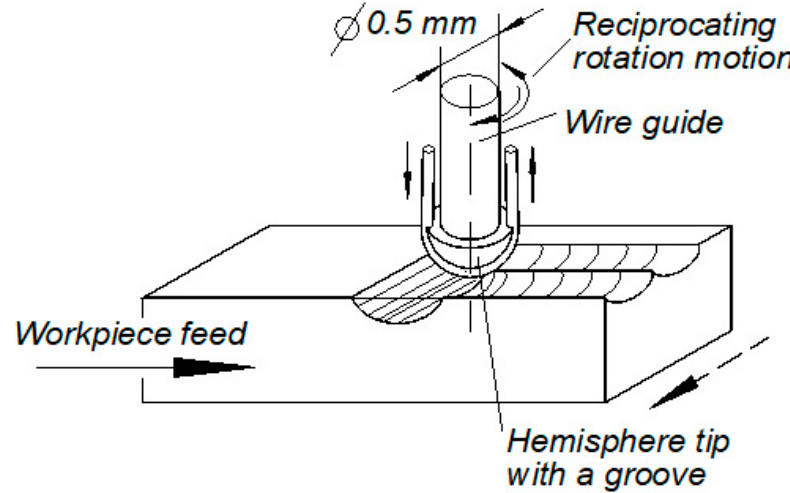
Figure 4. Redrawn figure of the wire electrical discharge (WED) milling (ref. [26]).